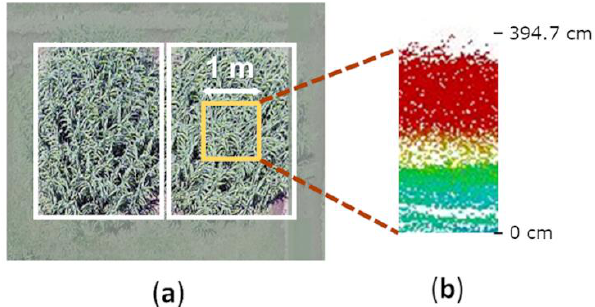
Figure 3. Aerial drone photograph and three-dimensional (3D) light detection and ranging (LiDAR) point cloud for EcoA under moderate drought stress (mDr) conditions. ( a ) Aerial image of EcoA, from flying the unmanned aerial vehicle (UAV) (Figure 2) over the mDr experimental plot. Marked in yellow is the 1 m 2 area of interest at the center of the plant. ( b ) 3D LiDAR point cloud color coded by